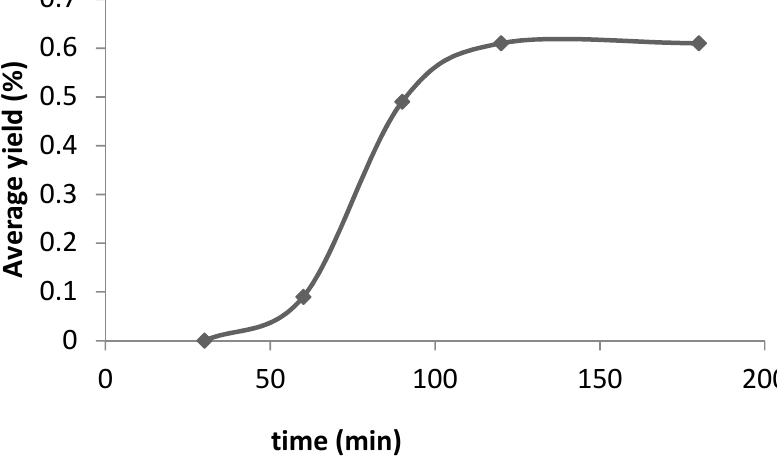
Figure 1. Extraction kinetics of the essential oil of Marrubium vulgare .